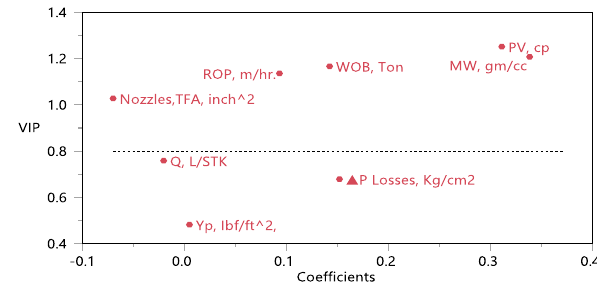
Fig. 17 VIP versus coefficient for ECD model (prior to